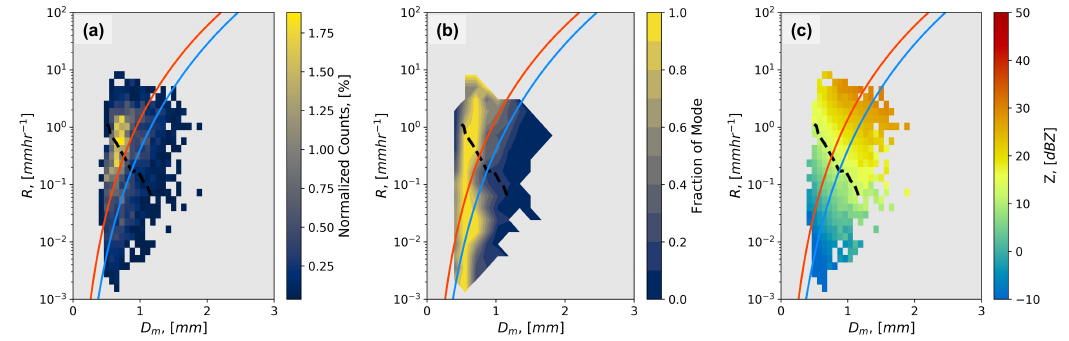
Figure 5. As in Figure 3, but now for the snowfall PSDs collected in Finland. The x and y axis are in their liquid equivalent values (see Section 2.2.2) ( a ) Counts of observations on the R − D m plane normalized by the total number of observations and converted to percentages. The same relations of R − D m Figure 2a are shown for reference. ( b ) Same data as ( a ), but the data are normalized to the total number of observations in each bin of R . A value near one implies that it is near the mode of observations in that bin of R . ( c ) Same 2D histogram as ( a ), but colored by the bin median value of Ku-band calculated Z e from the PSD using the method described in Section 2.2.2.